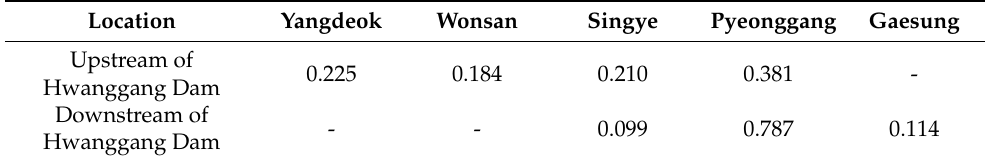
Table 1. Th weights of the weather stations for the Thiessen polygon in the study area.